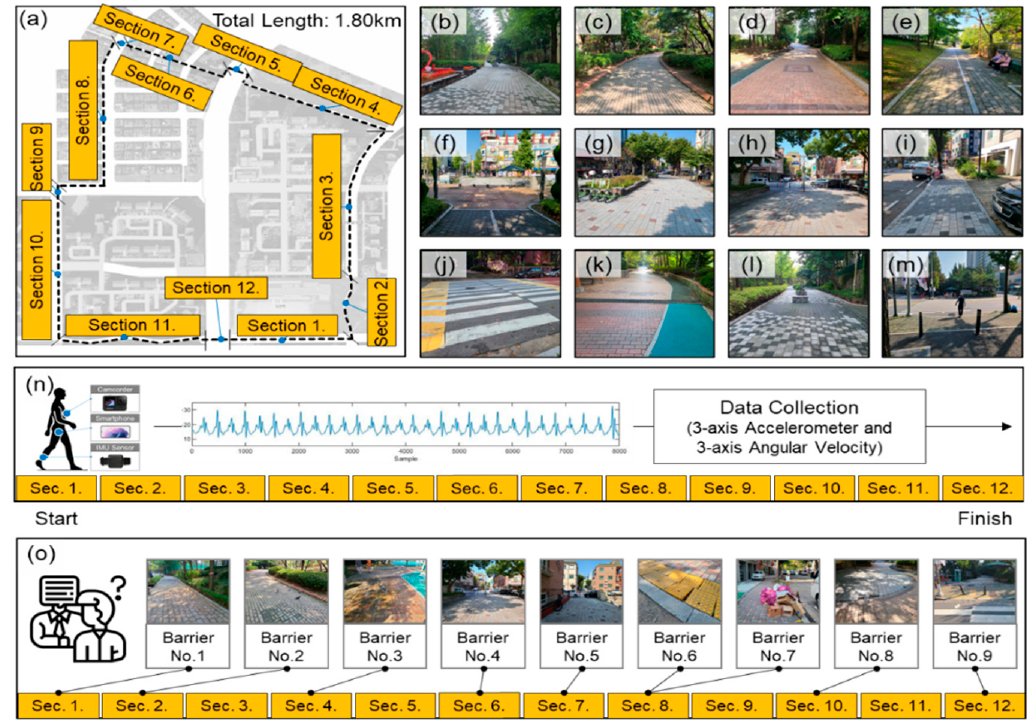
Figure 3. Graphical summary of experimental site and procedure; ( a ) site and sections; ( b – m ) rep- resentative pictures of each section; ( n ) first stage of experiment (data collection); and ( o ) second stage of experiment (examination and record of environmental barrier expressed by participants).